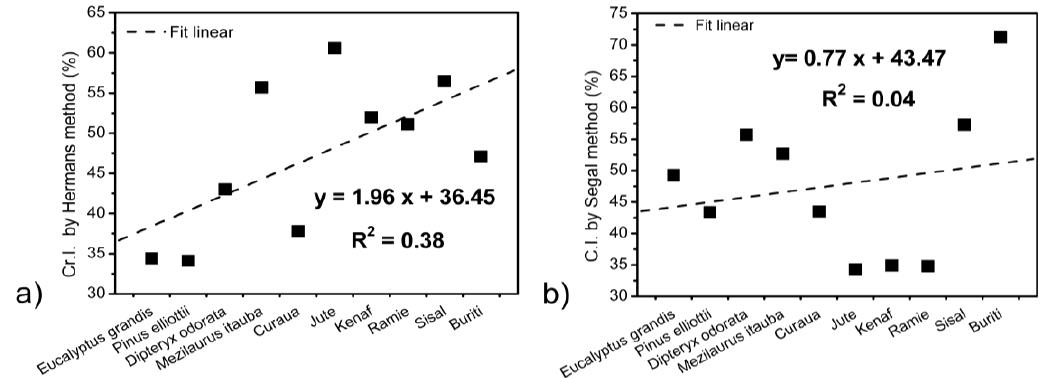
Figure 3. Liner regression comparing the Hermans ( a ); and Segal ( b )